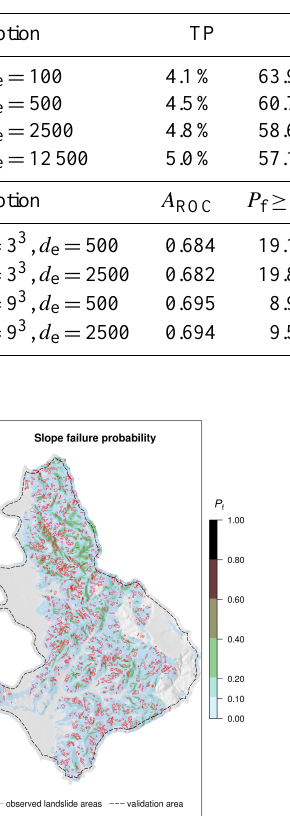
Table 5. Characterization of model results and computing times. Prediction rates: TP = true positive, TN = true negative, FP = false positive, FN = false negative.